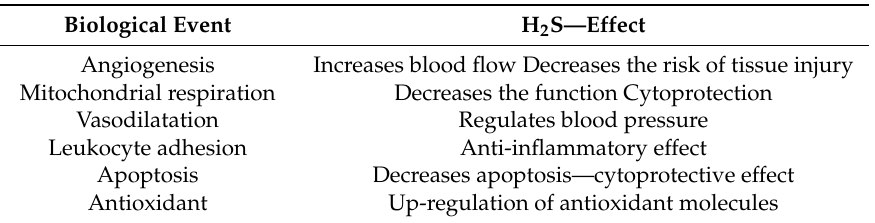
Table 1. Hydrogen sulfide—systemic effects.